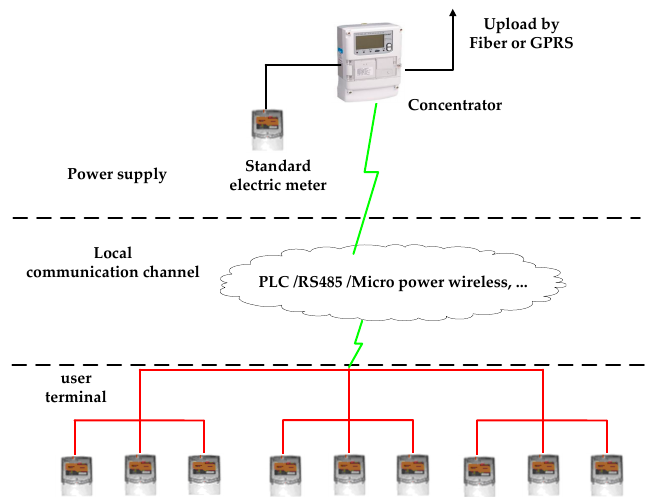
Figure 2. Electric meter data acquisition physical architecture based on AMI.